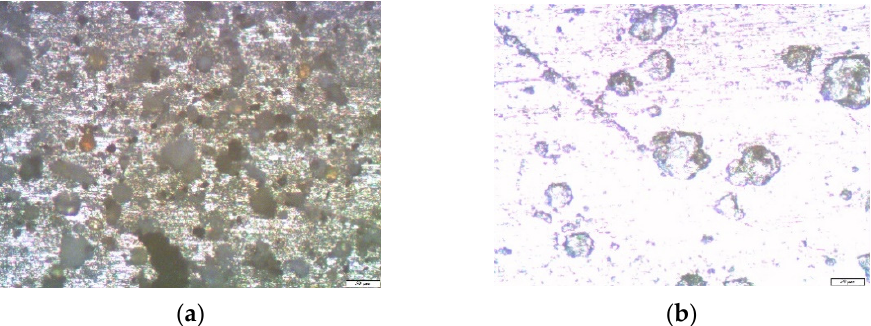
Figure 8. Micrographs of the surface area of the zinc sample, pre-modified with a 1% VS solution, after conducting full-scale, one-year natural tests in an urban atmosphere: ( a ) immediately after testing but before the removal of the corrosion products; and ( b ) after the removal of the corrosion products.